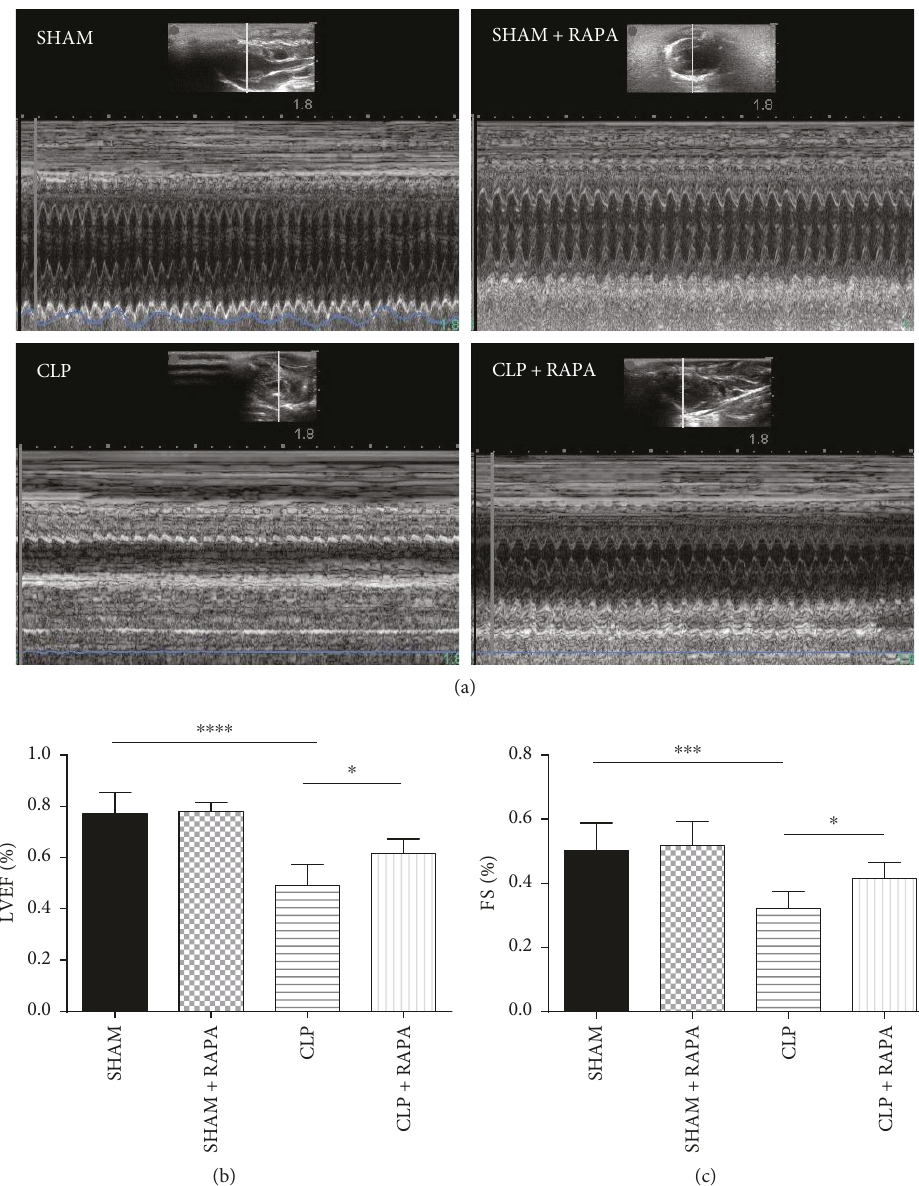
Figure 2: Cardiac functions examined by echocardiography. Representative echocardiographic recordings from the four groups (a). LVEF and FS were measured (b). Mean ± SD, six rats per group, ∗ p < 0 05 ; ∗∗∗ p < 0 001 ; ∗∗∗∗ p < 0 0001 . LVEF, left ventricle ejection fraction; FS, fraction